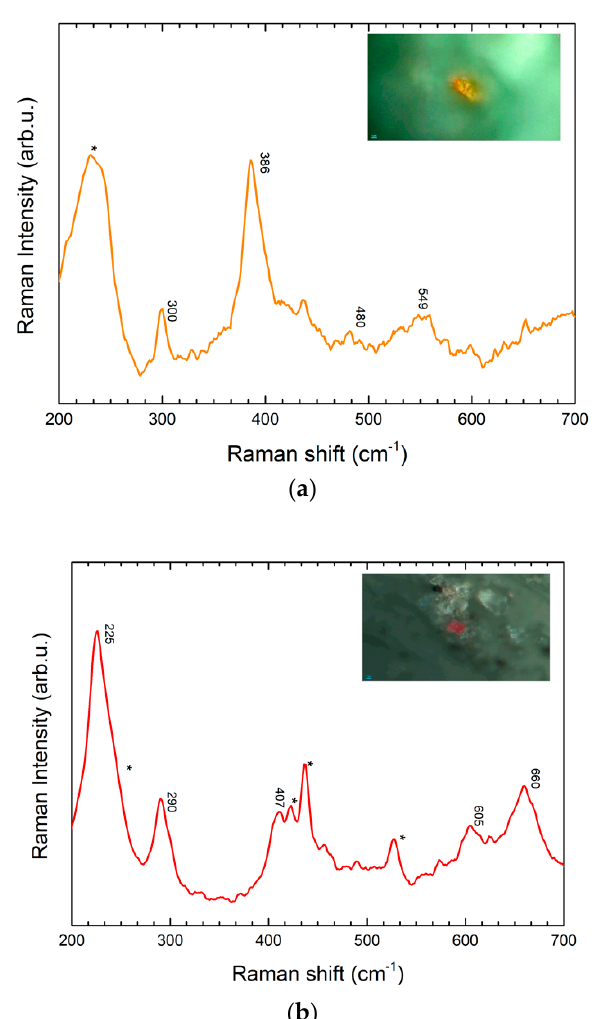
Figure 7. ( a ) SERS spectrum (orange line) of sample collected with GT-SERS of a yellow particle from area 2 with characteristic peaks of goethite. ( b ) SERS spectrum (red line) of a sample collected with GT-SERS of a yellow particle from area 2, with characteristic peaks of hematite. Asterisks are indicative of gel substrate peaks.